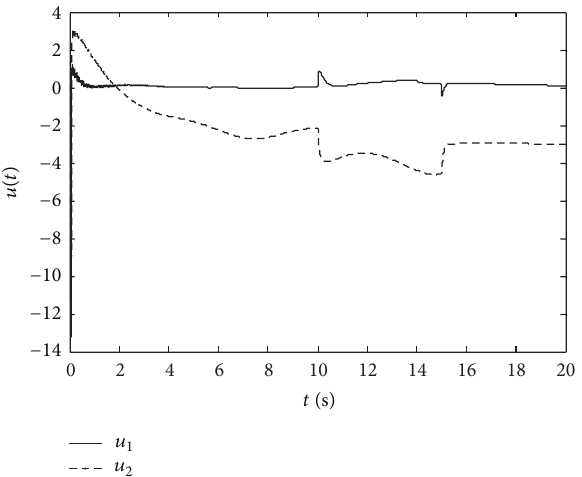
Figure3:Thecurveof 𝑢(𝑡) withtheproposedcontrolscheme((29a), (29b), and (29c)).